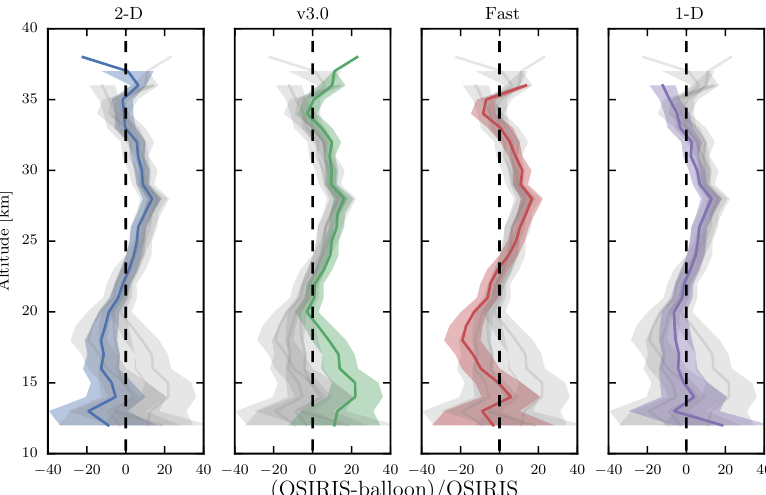
Figure 7. Same as Fig. 6, but the bias is an average over individual differences between OSIRIS and balloon correlative data. The average and standard error of the individual biases are converted to relative quantities by dividing by the corresponding average OSIRIS NO 2 profile (scaled to balloon local